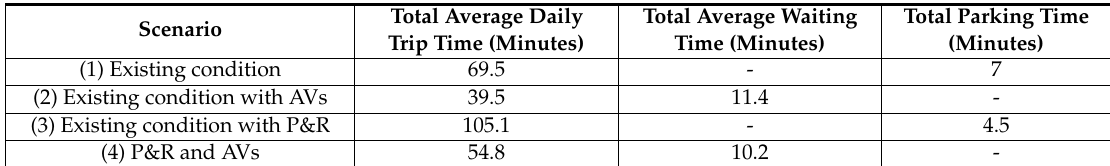
Table 6. Trip time comparison of conventional modes and AVs.